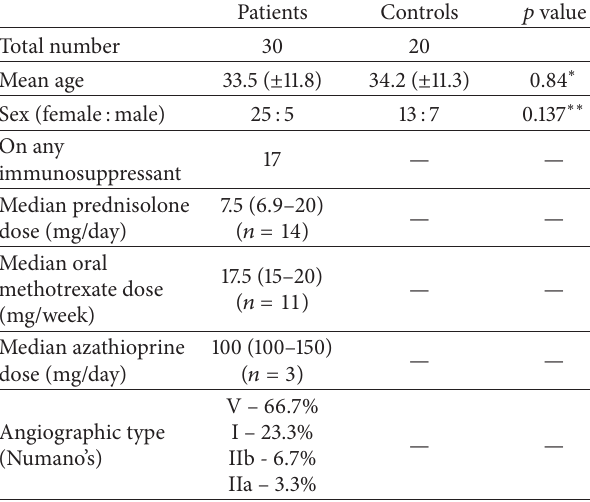
Table 1: Demographic details of patients and